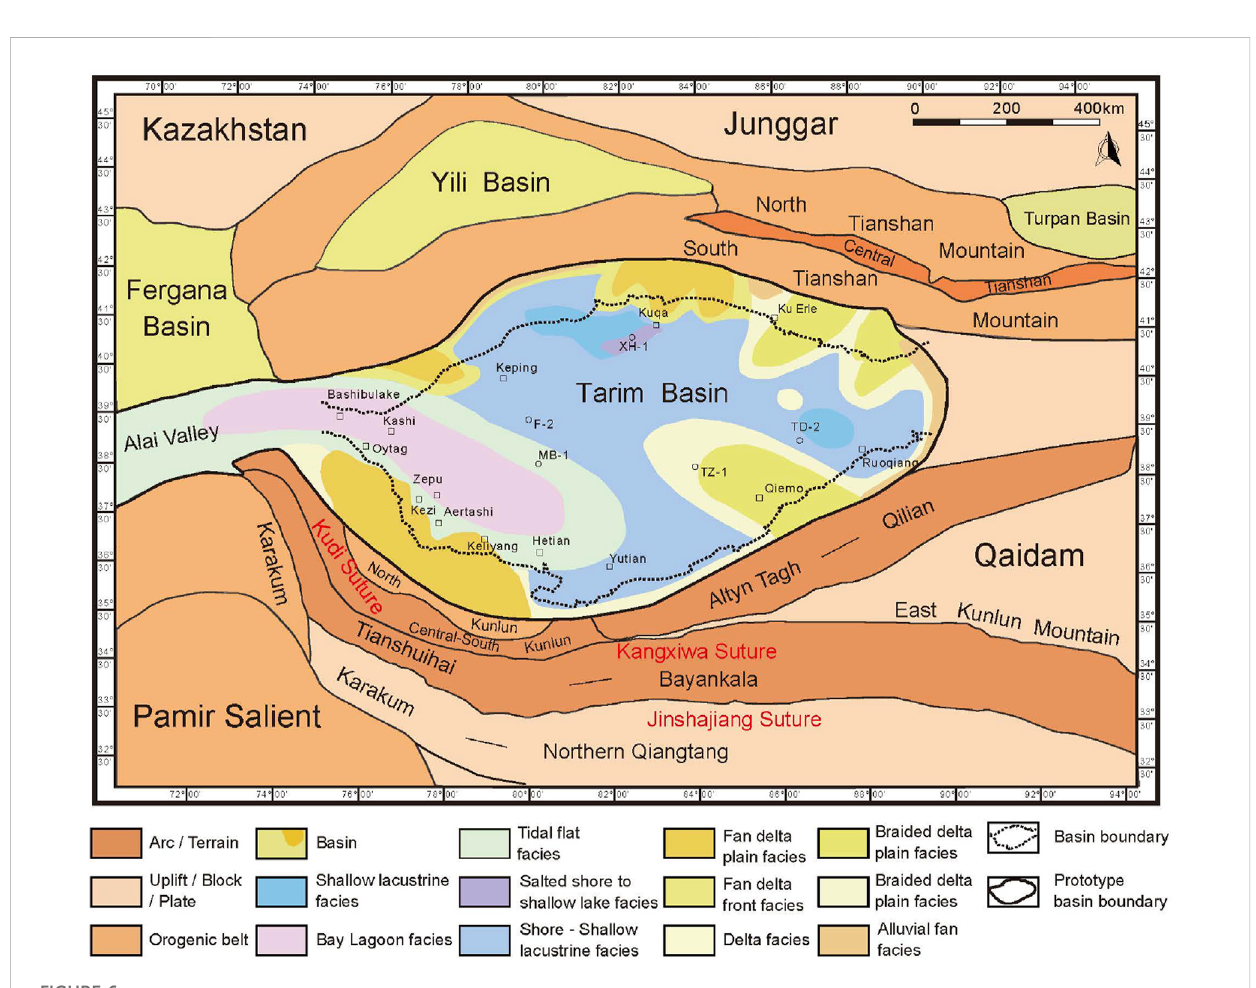
FIGURE 6 The Tarim proto-type basin and its periphery in the Late